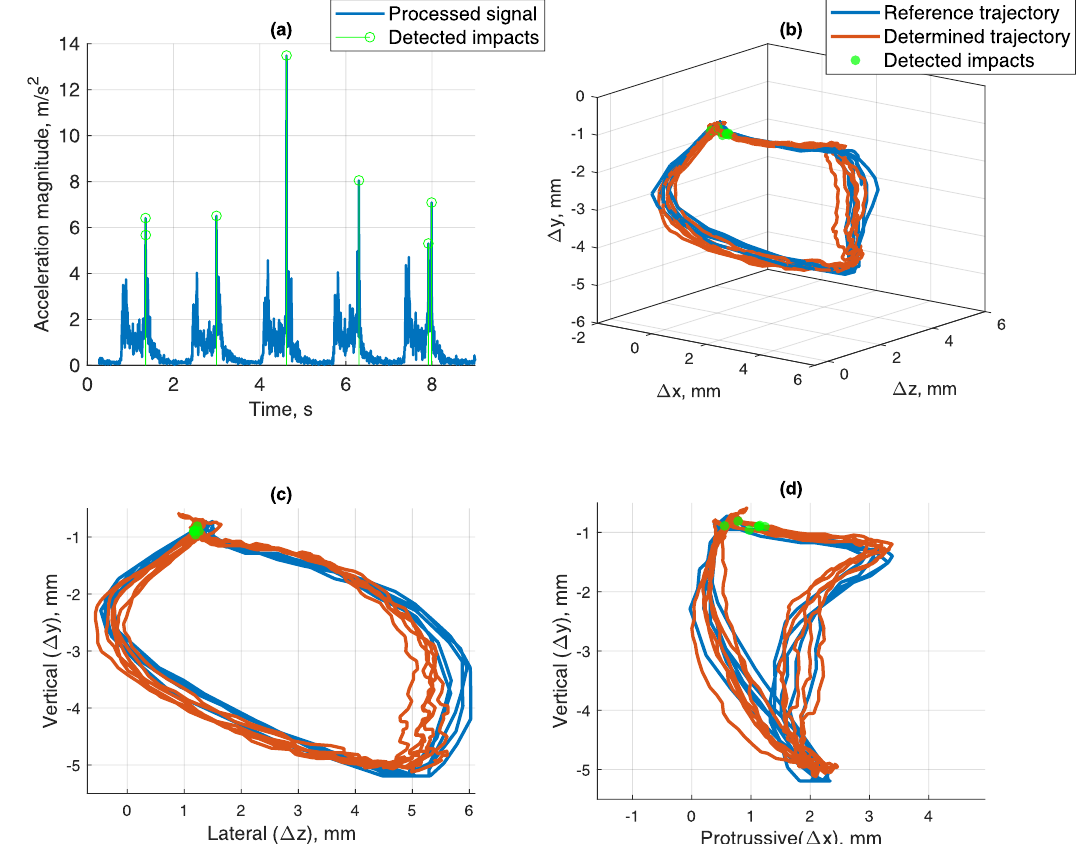
Figure 14. ( a ) Teeth impact detected by an experimentally selected threshold of 5 m/s 2 , set on acceleration vector’s magnitude value (RSS of X, Y and Z components). ( b ) Masticatory trajectory determined by magnetic position tracking and reference methods, while detected teeth impacts are marked at the points of detection. 3D view. ( c ) Lateral–vertical view (z-y). ( d ) Protrussive–vertical view